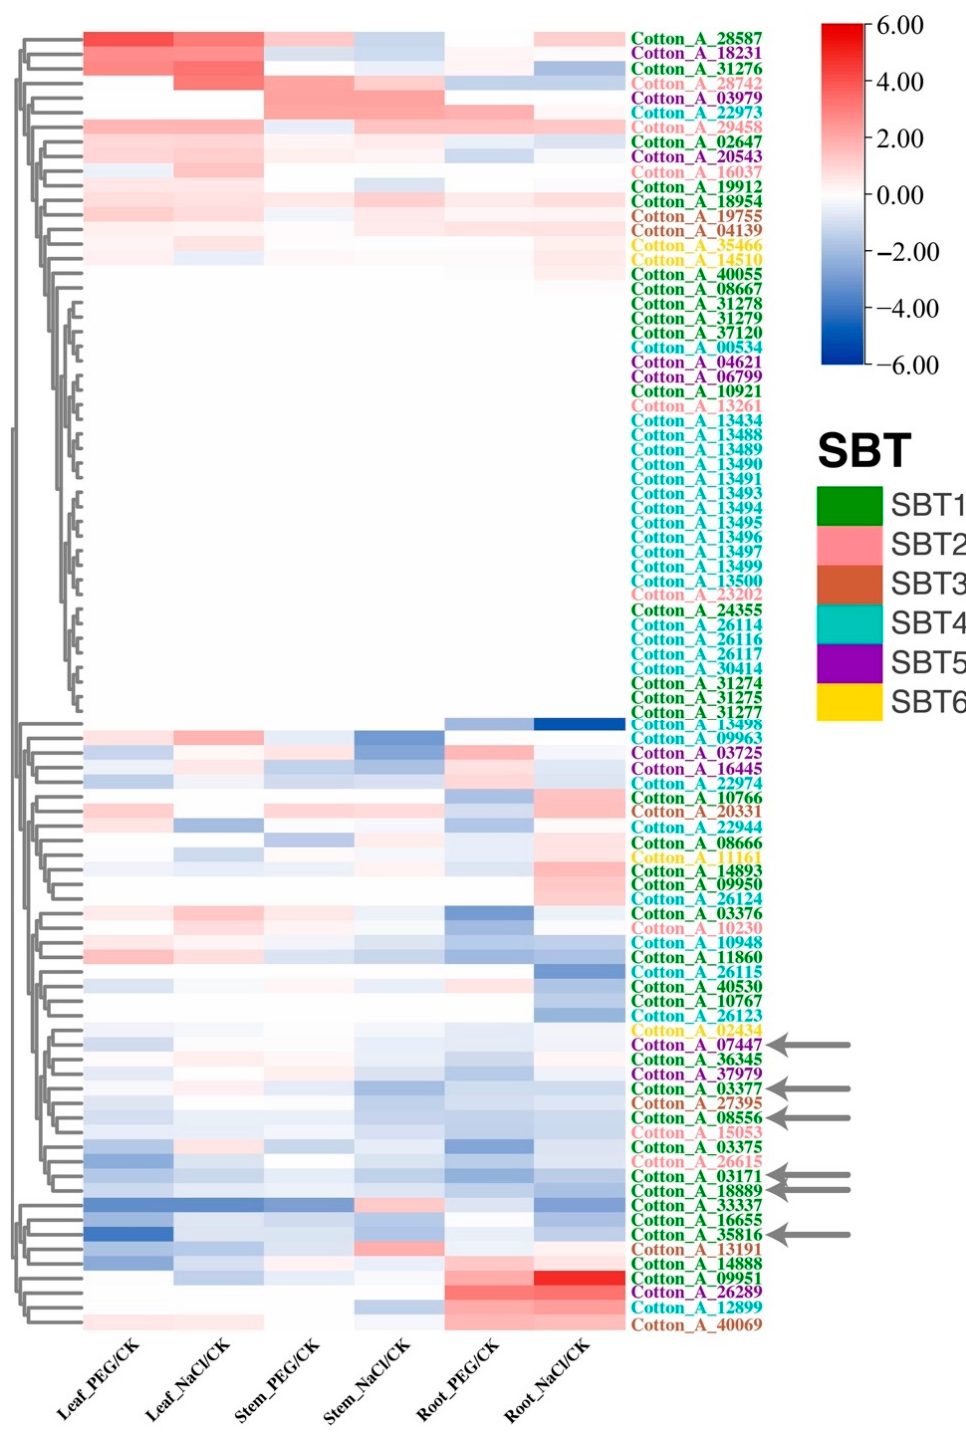
Figure 4. Expression profiles of 89 SBT gene families in Gossypium arboreum . There are 89 Gossypium arboreum gene family members in the vertical, and the ratio of PEG and NaCl treatment to control in leaf, stem and root tissues in the horizontal sequence, and the classification of each SBT gene family member is at the far right. Different color fonts indicate the subfamilies from SBT1 to SBT6. Dark green, pink, brown, cyan, purple and dark yellow lines represent subfamilies from SBT1 to SBT6, respectively.